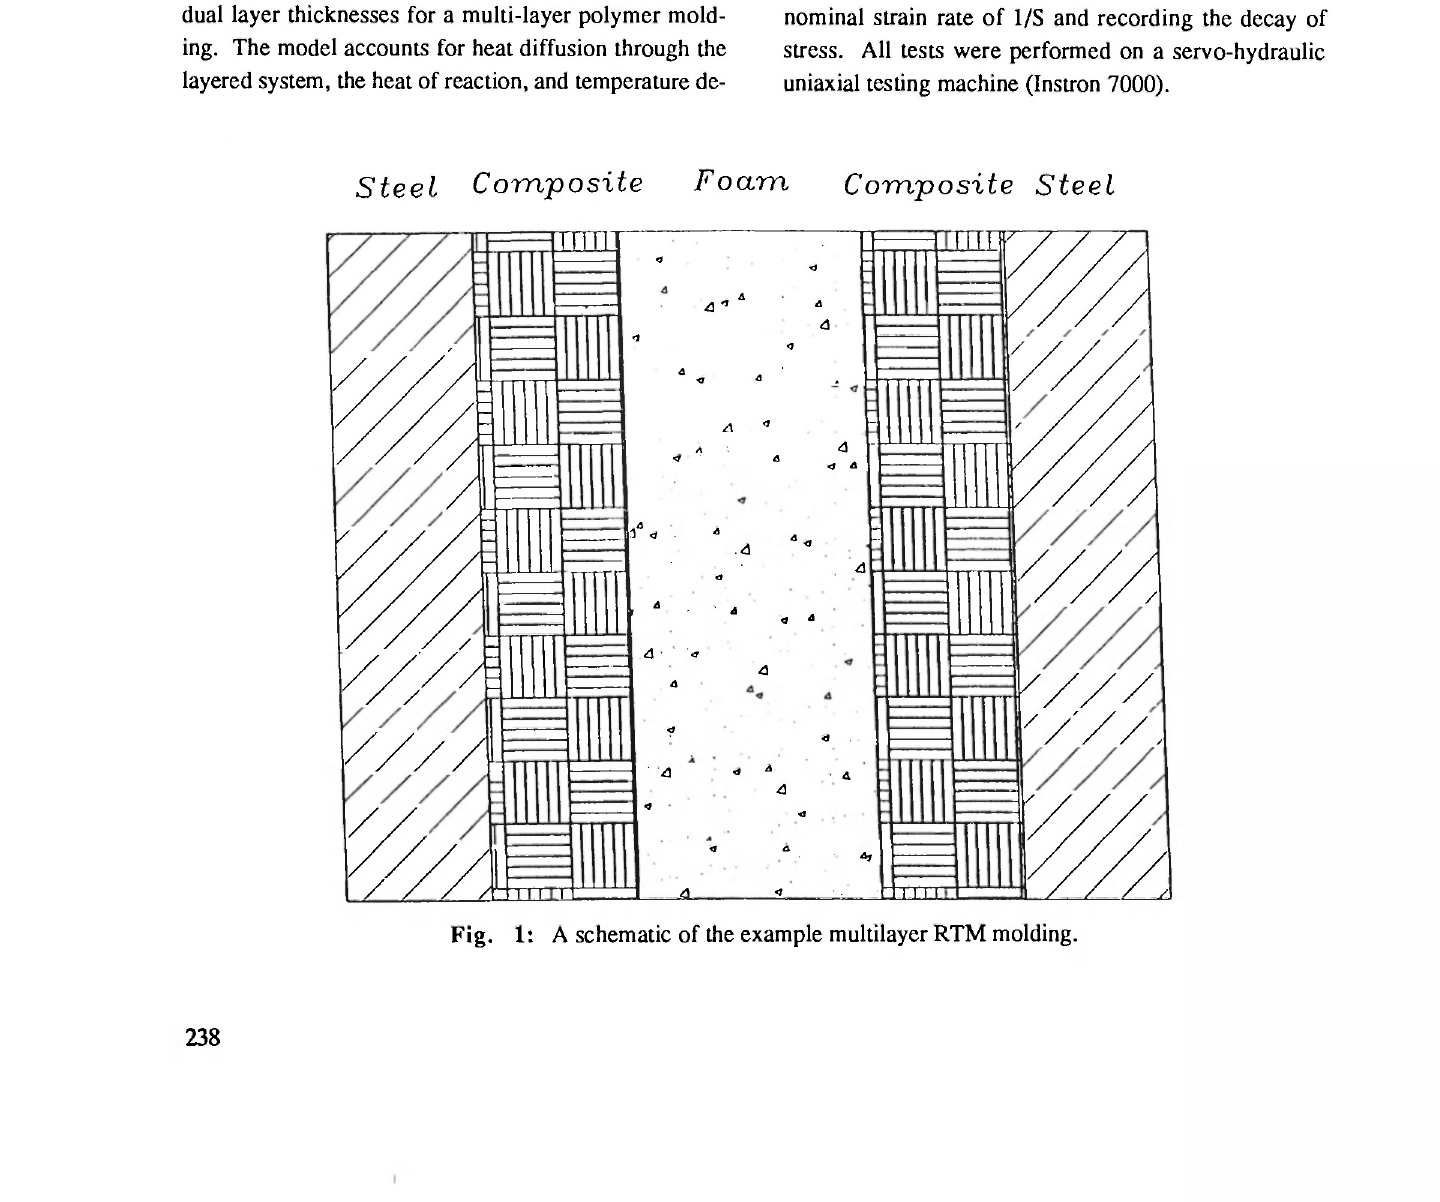
Fig. 1: A schematic of the example multilayer RTM